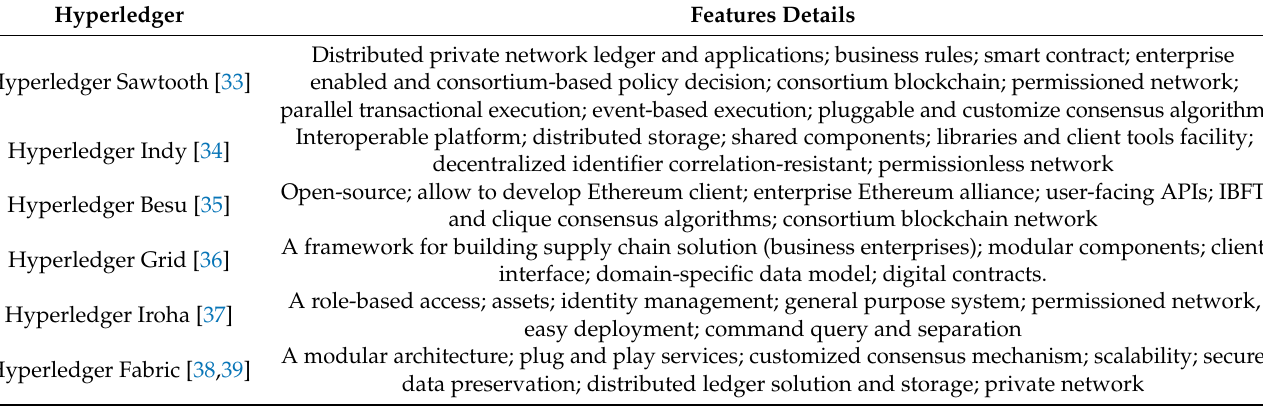
Table 2. Role of